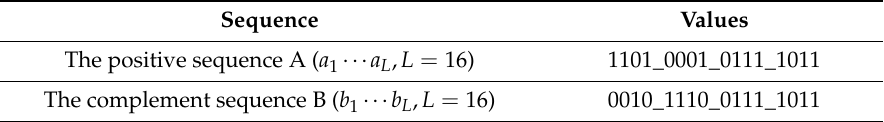
Table 2. The code sequences of 16-bit bi-phase complementary code.